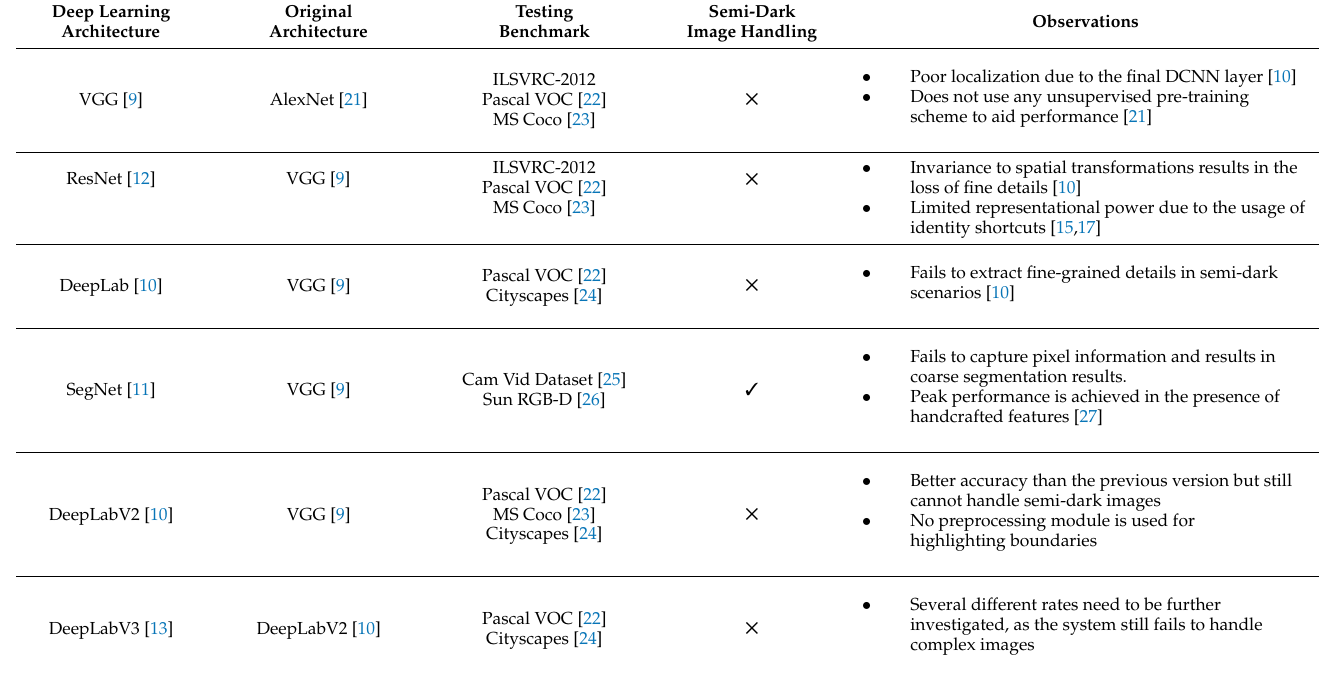
Table 1. Comparative Analysis of Semi-dark Image-Centric Semantic